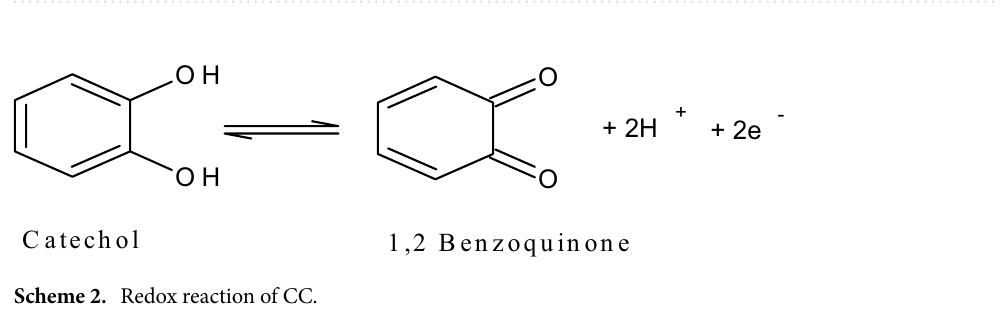
Figure 5. CVs curve 10 µM CC at unmodified CPE (scattered streak) and poly(CBBG)/MCPE (dashed streak) with scan rate 0.05 Vs -1 using 0.2 M PBS of pH 7.4.